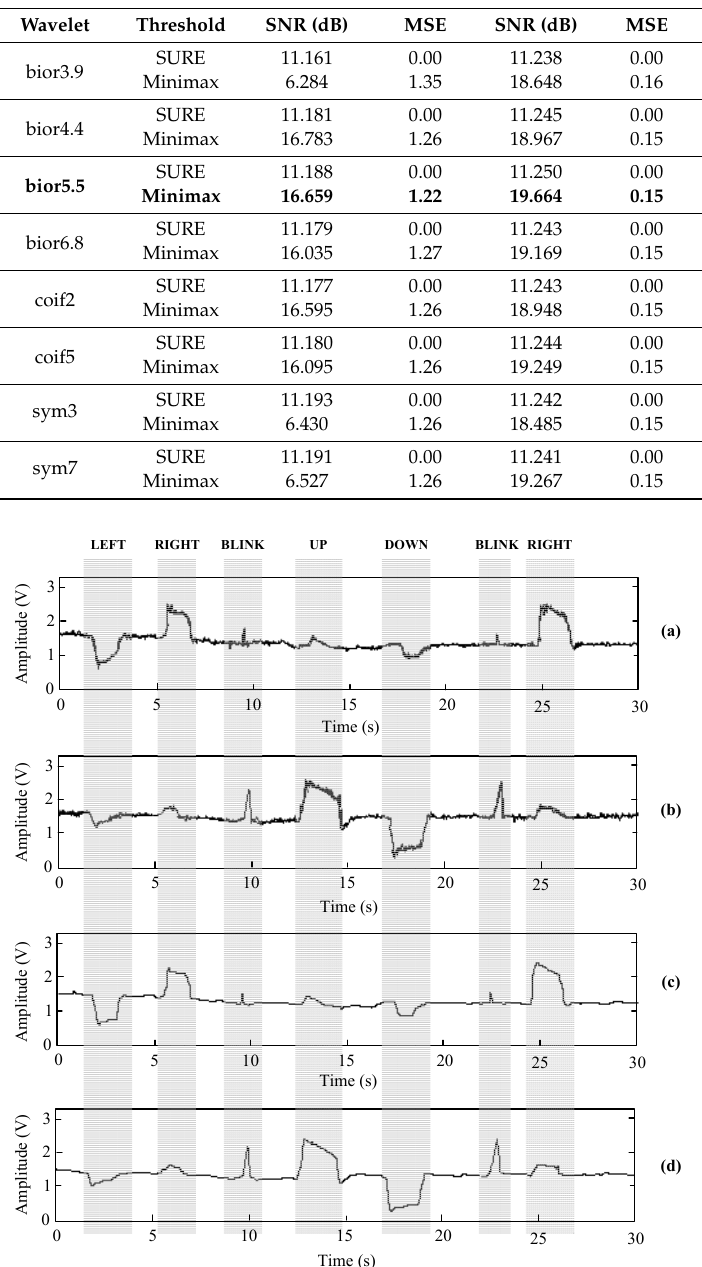
Figure 10. Waveforms of the raw and filtered EOG signals using UWT bior5.5 wavelet and Minimax thresholding: ( a ) Raw EOG signal obtained from horizontal eye movement. ( b ) Raw EOG signal obtained from vertical eye movement. ( c ) Denoising of raw EOG signal obtained from horizontal eye movement. ( d ) Denoising of raw EOG signal obtained from vertical eye movement.